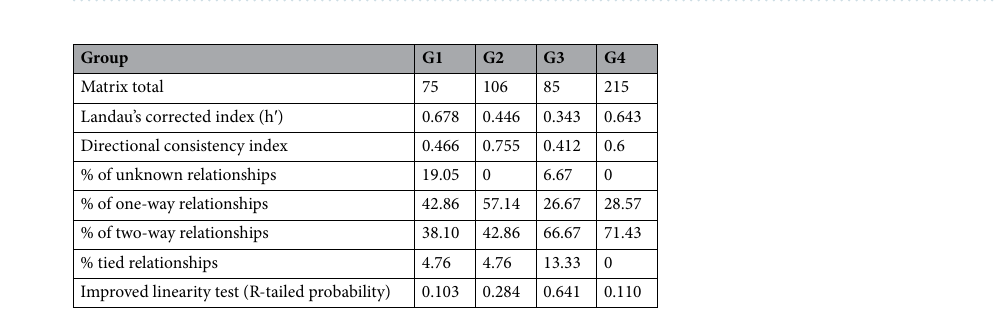
Table 1. Results from the Matman test for linearity of dominance hierarchies for the four study groups of